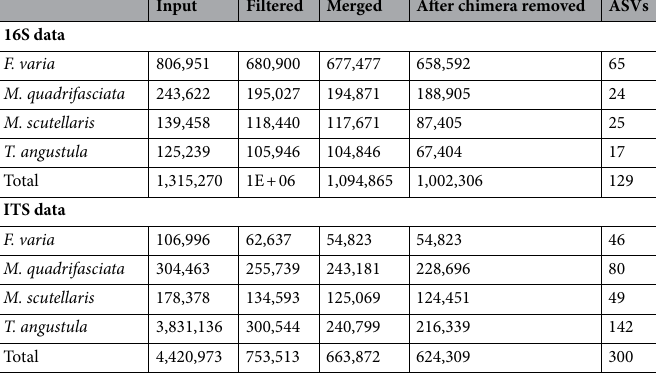
Input Filtered Merged After chimera removed